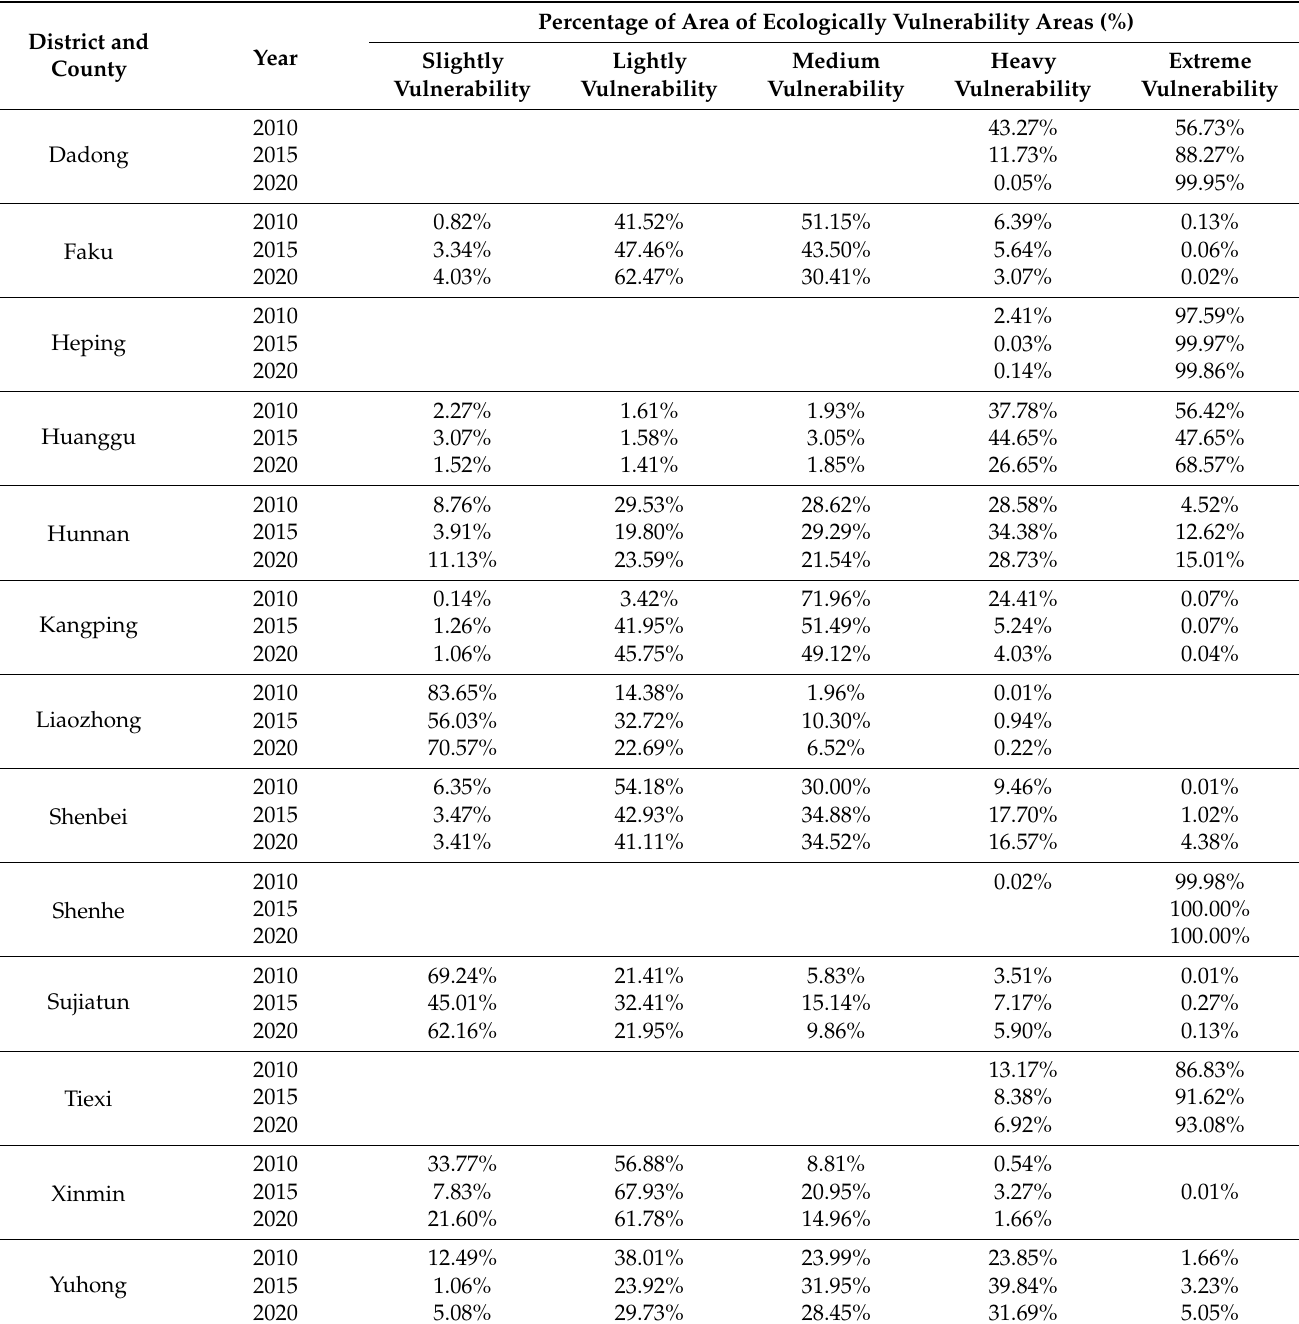
Table 5. Percentage of ecologically vulnerable areas in each district and county of